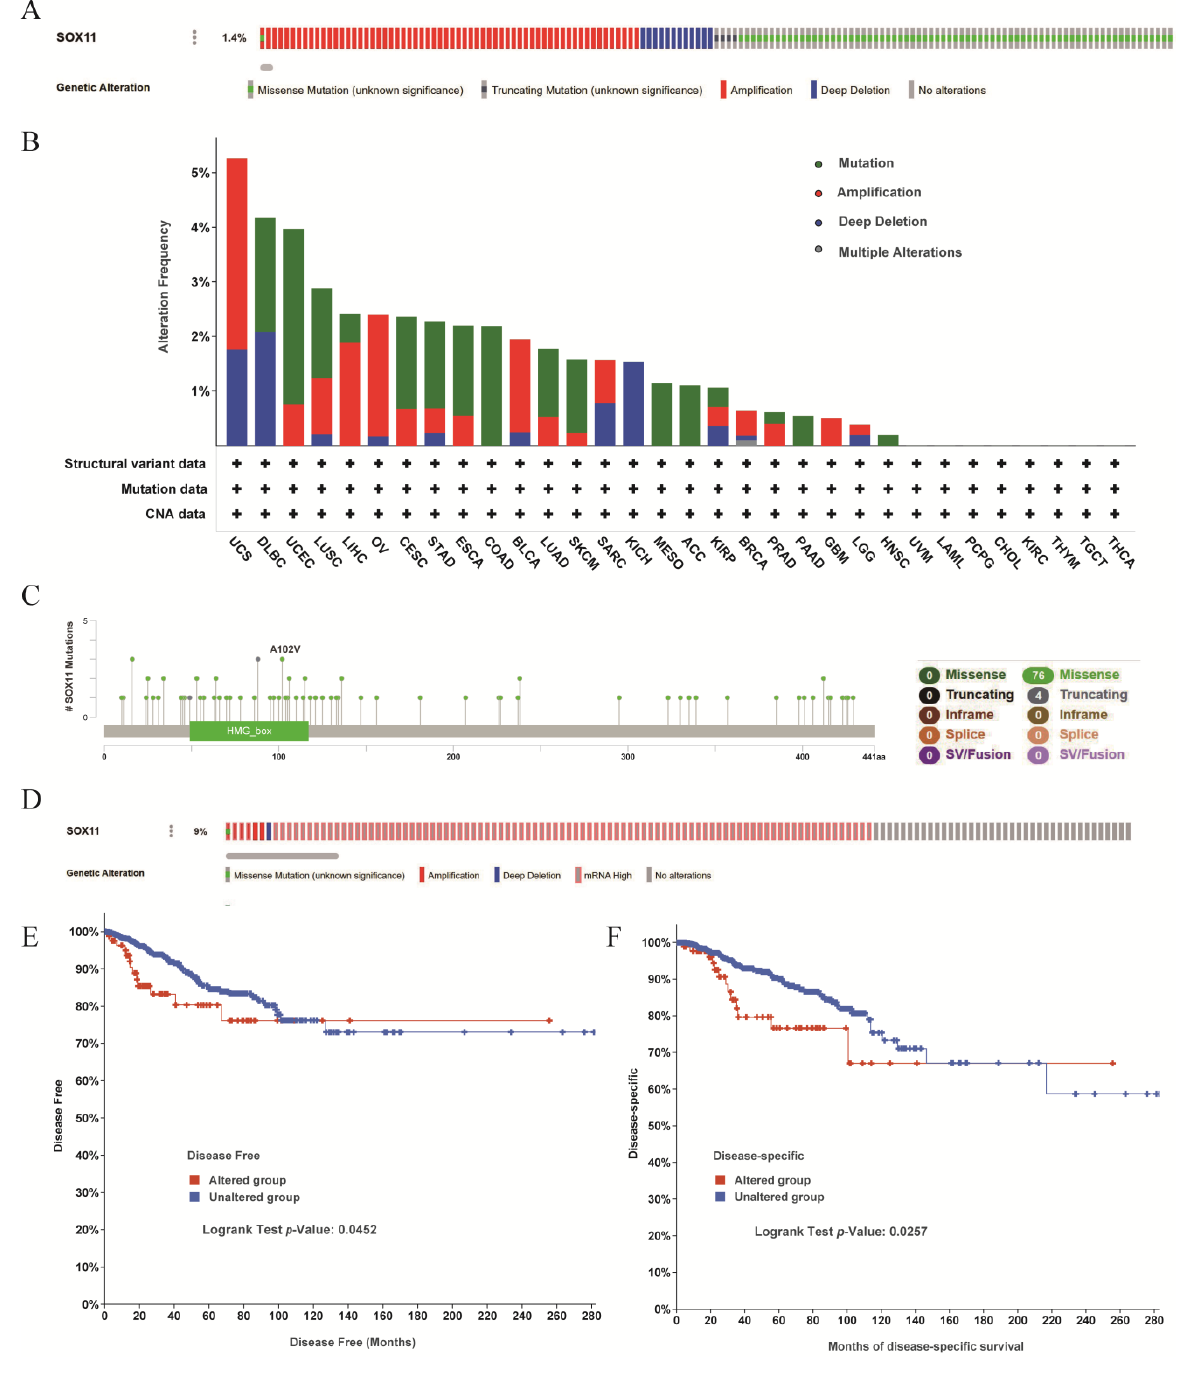
Figure 6. Pan-cancer SOX11 alterations from The Cancer Genome Atlas (TCGA). ( A ) OncoPrint visual summary of SOX11 alterations in TCGA pan-cancer datasets. Four types of genetic alterations were defined: Missense Mutation (unknown significance), Truncating Mutation (unknown significance), Amplification and Deep Deletion ( B ) A comprehensive view of the alteration frequency of SOX11 in TCGA pan-cancer datasets. “+” represents that the dataset contained the indicated data. ( C ) Analysis of the mutation sites and mutation types in SOX11 . ( D ) OncoPrint summary of the alterations on SOX11 in TCGA BRCA dataset. Four types of genetic alterations were defined: Missense Mutation (unknown significance), Amplification, mRNA high and Deep Deletion ( E ) Kaplan–Meier analysis of disease-free survival in TCGA BRCA cohort with altered or unaltered SOX11 . ( F ) Kaplan–Meier analysis of disease-specific survival in TCGA BRCA cohort with altered or unaltered SOX11